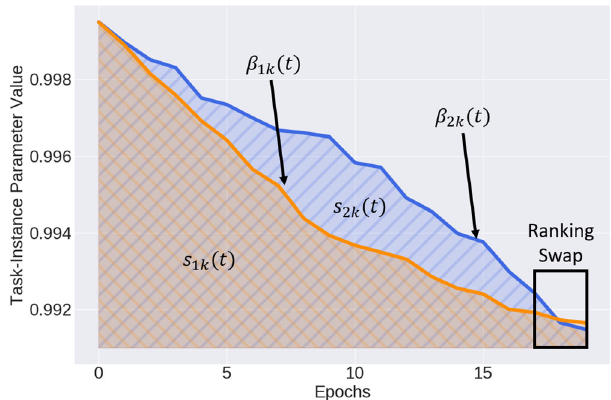
Fig. 6 Trajectory of β 1 k and β 2 k on task k . Ranking instances based on β ( t